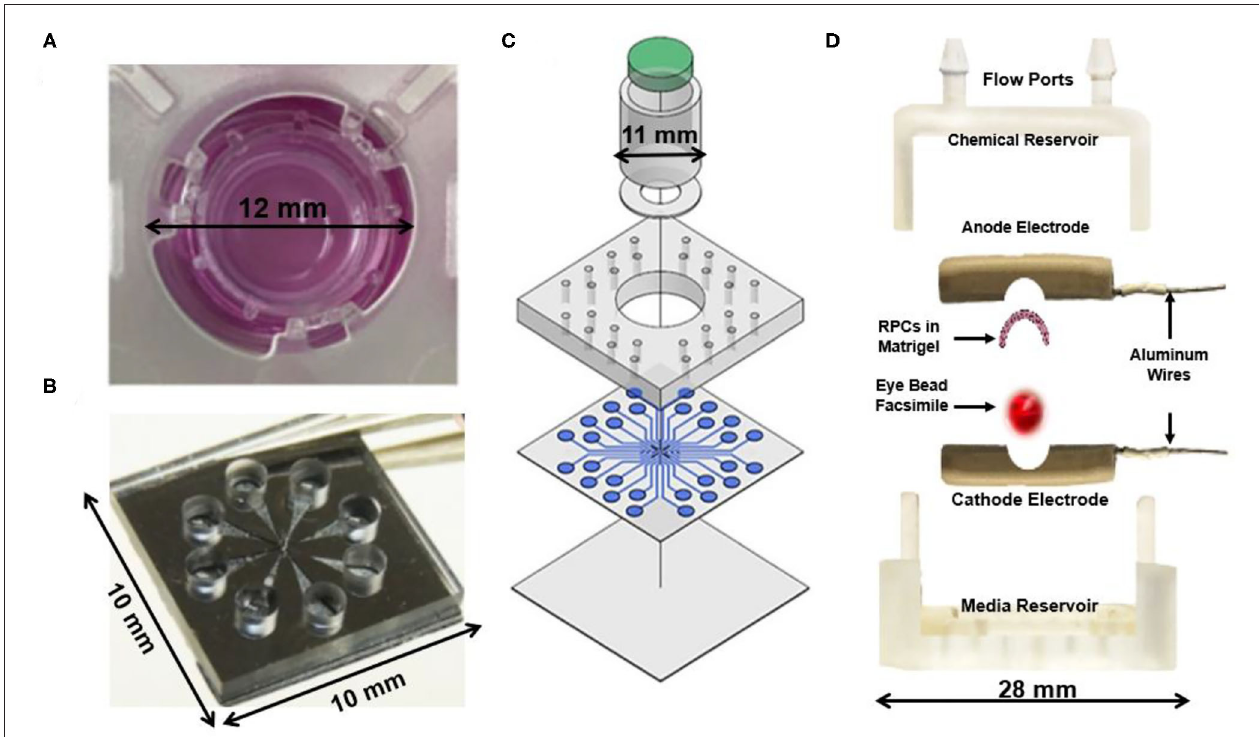
FIGURE 1 | Current hybrid explant systems for studying the retina. (A) An ex vivo chamber for a porcine retina explant capable of maintaining tissue viability for 1–2 weeks to enable long-term investigation of the ex vivo retina (Rettinger and Wang, 2018). (B) A glutamate perfusion system to stimulate retinal neurons with neurotransmitters to augment the phototransduction process that occurs within the body ( Rountree et al., 2017). (C) Retina on a chip microfluidic perfusion assay system for point access delivery of therapeutics to specific parts of the rat retina (Dodson et al., 2015). (D) Ex Vivo Eye Facsimile (EVES) hybrid explant system designed for delivery of electrical and chemical stimulation to a whole-enucleated eye explant from mouse (Vazquez et al.,